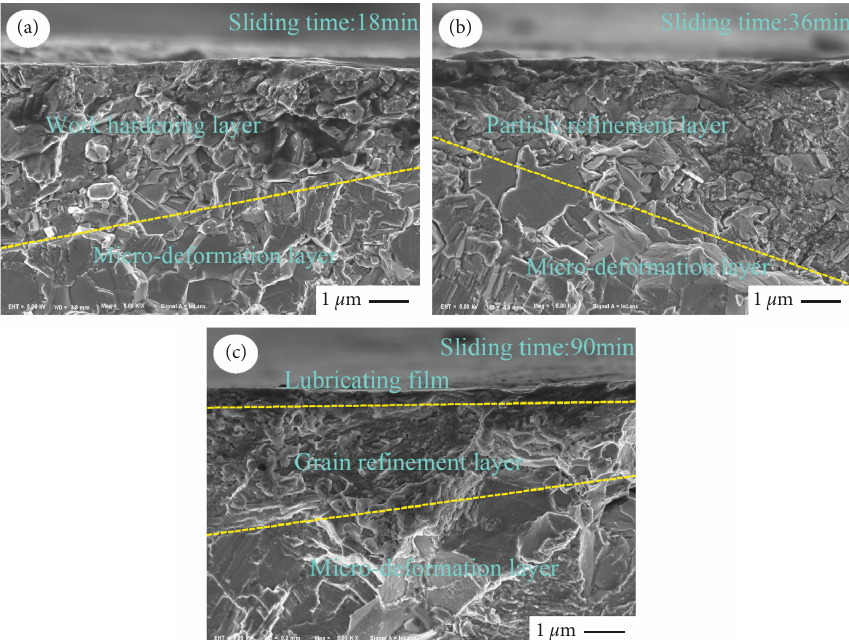
Figure 6: Typical FESEM morphologies of the wear scar cross-sections of the TASC at 18 (a), 36 (b) and 90min (c).